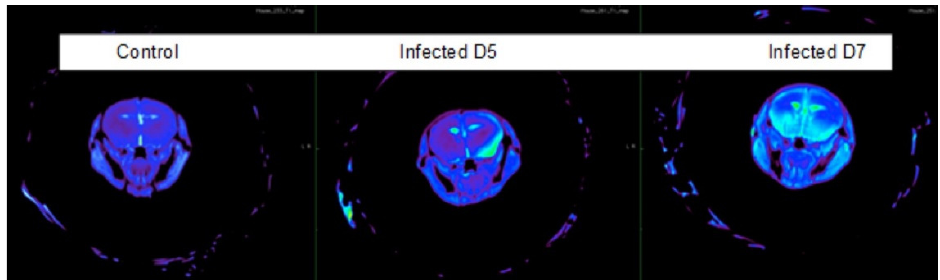
Figure 3. Blood–brain barrier permeability over time. These images represent one control mouse unexposed to WNV at 5 DPI and two mice infected with WNV at 5 and 7 DPI. An increase in color is indicative of higher signal intensity.